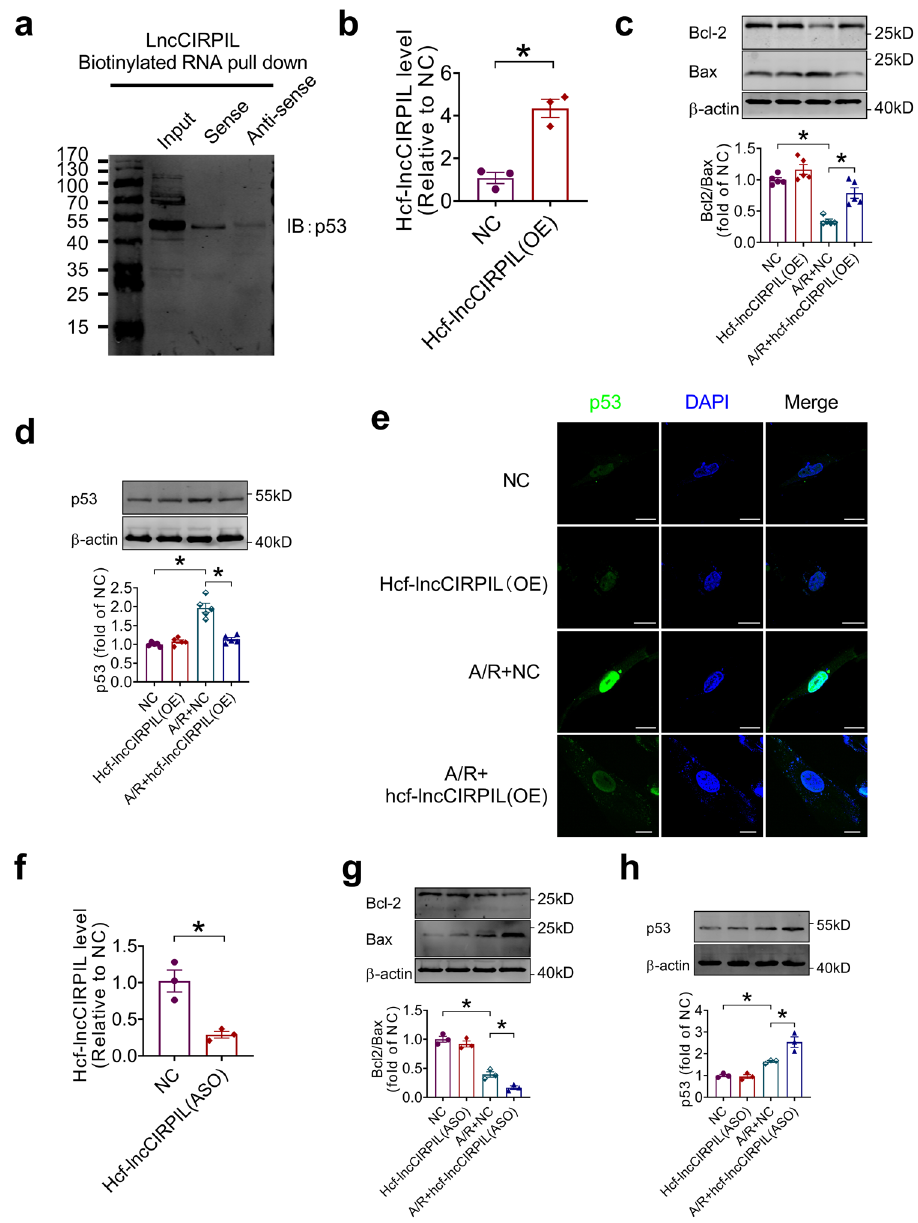
Fig. 8 The effects of human conserved fragment of lncCIRPIL (hcf-lncCIRPIL) on human AC16 cells exposed to A/R insult. a Western blot of p53 pulled down by sense sequence of hcf-lncCIRPIL in human AC16 cells. n = 3. b The level of hcf-lncCIRPIL in AC16 cells transfected with hcf-lncCIRPIL overexpression plasmid. n = 3. * P < 0.05 vs NC by two-tailed Student ’ s t test. c , d Effects of hcf-lncCIRPIL overexpression on Bcl2/Bax ratio and p53 level in AC16 cells exposed to A/R insult. n = 5. * P < 0.05 by one-way ANOVA followed by Tukey post hoc analysis. e Effects of hcf-lncCIRPIL overexpression on p53 cellular distribution. n = 3. Scale bar = 20 μ m. f . Knockdown ef fi ciency of hcf-lncCIRPIL by the antisense oligonucleotide (ASO). n = 3. * P < 0.05 vs NC by two-tailed Student ’ s t test. g , h Effects of hcf-lncCIRPIL-ASO on Bcl2/Bax ratio and p53 level in AC16 cells exposed to A/R insult by. n = 3. * P < 0.05 by one-way ANOVA followed by Tukey post hoc